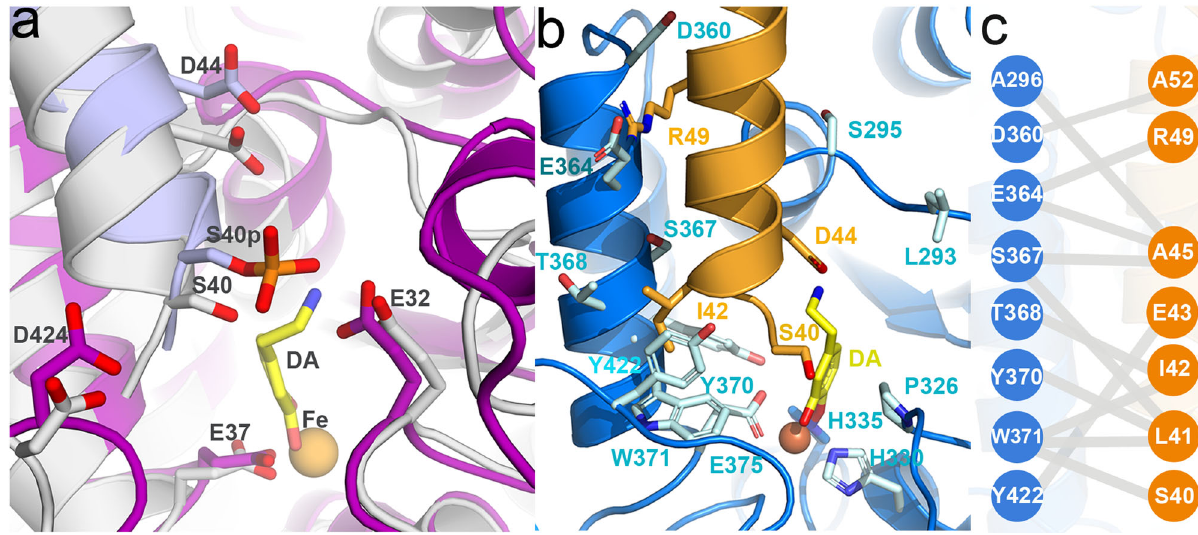
Fig. 6 Modelling of the TH active site. a Modelling the effect of S40 phosphorylation on the interaction of the N-terminal α -helix with DA. Representative conformations from the last 50 ns of the 500 ns MD simulations for TH(DA) (grey ribbon) and pS40-TH(DA) (light blue ribbon). See “ Methods ” for preparation of the representative conformation. The resulting structures show a slight shift of the N-terminal α -helix upon phosphorylation, most probably due to electrostatic repulsion between the phosphate and E325, E375 and D424. b A detailed view of the atomic model of the TH(DA) active site. (left) The N-terminal α -helix (orange), which establishes connections with the adjacent helix D360-E375 and with residues of the 290 – 297 and 420 – 429 loops (blue, right). c A cartoon depicting the interactions established between residues of the N-terminal α -helix that enters the active site, and residues of adjacent